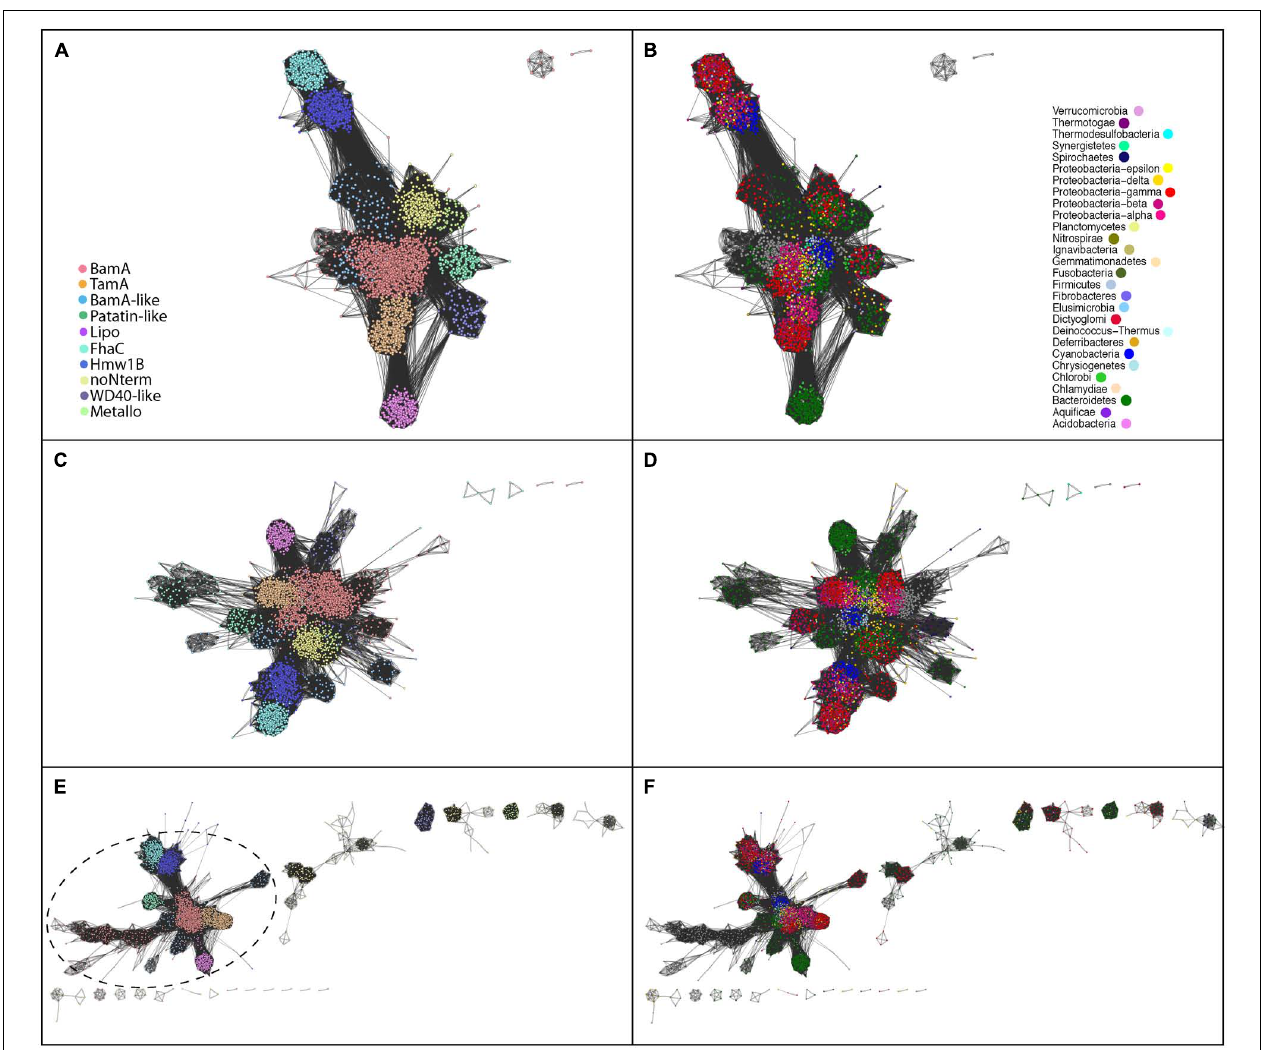
FIGURE 2 | Distinctions between the Omp85/TpsB subgroups in sequence similarities. (A) Protein–protein similarity network representation of full-length sequences, demonstrating the ten bacterial subfamilies; due to its origin from bacterial BamA the eukaryotic sequences were included to the BamA subfamily. (C) The similarity network representation of barrel-domain sequences and (E) the similarity network representation of N-terminal domain sequences, where the